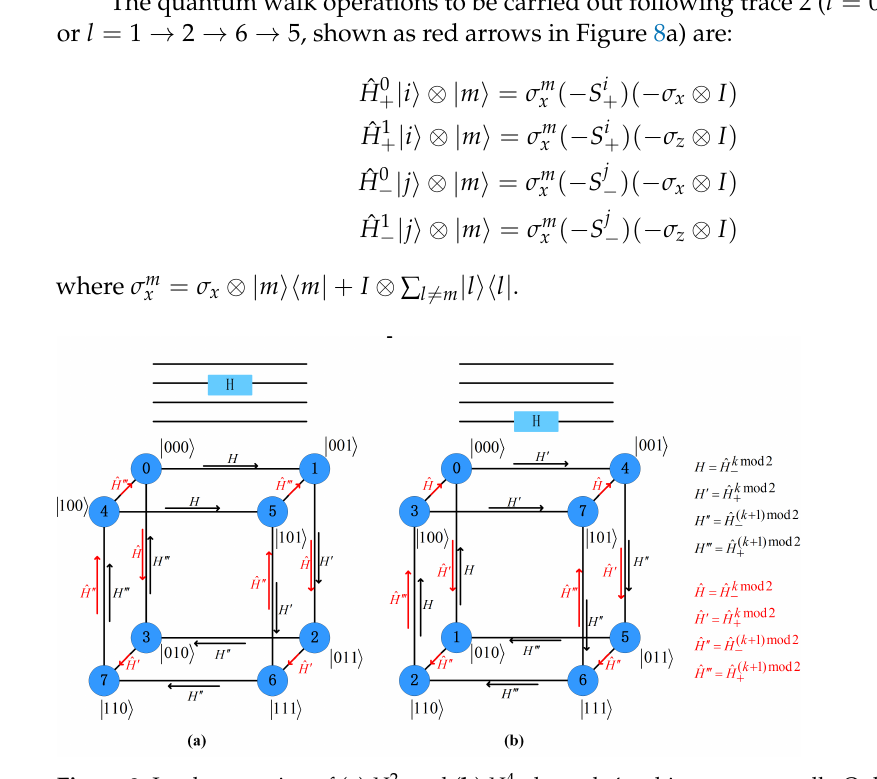
Figure 8. Implementation of ( a ) U 2 and ( b ) U 4 through 4-qubit quantum walk. Qubit 2, 3, and 4 are H H used to determine the 8 positions in Hilbert space and actual Hadamard operation is performed on qubit 1. The operator on the arrow indicates the operation performed on the walker if the walker occupied the starting position of the arrow. Additionally, the specific operations are listed in detail on the right side. The black arrows correspond to the trace 1 while the red arrows correspond to the trace